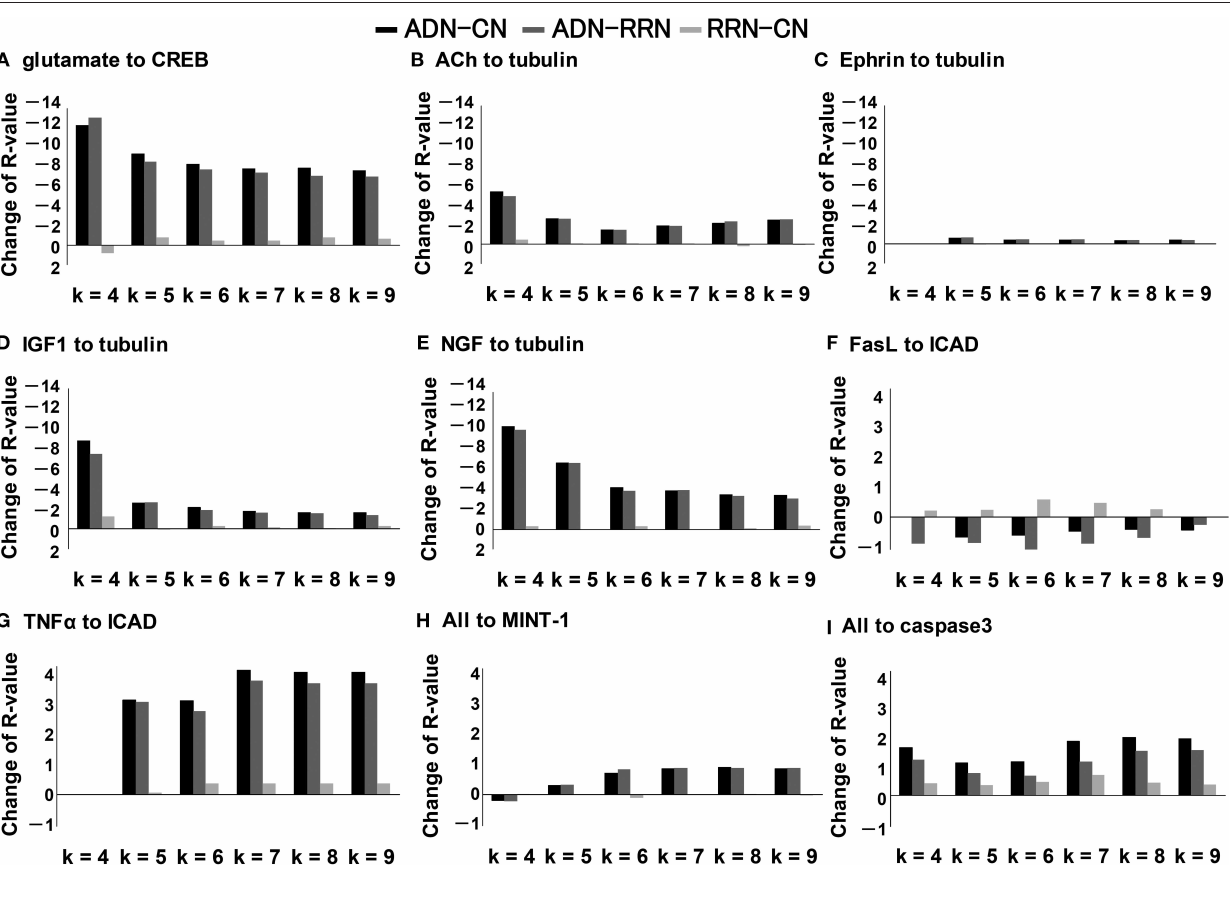
in robustness was large for the pathways involved with NGF, which has a maintenance function in nerve cells, and ACh, which decreases as A β accumulates. (F, G) Change in the number of pathways associated with neural cell death: inputs are FasL and TNF α , and output is ICAD. (H, I) Accumulation of APP: all inputs to MINT-1 as output (H) and to caspase 3 as output (I)